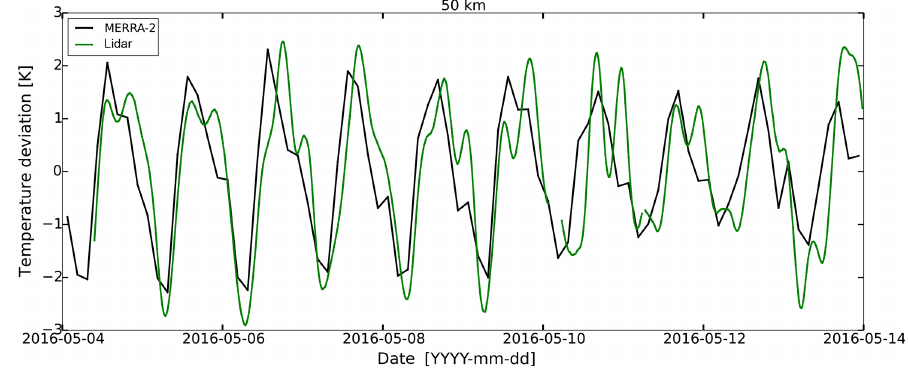
Figure 3. Comparison of tidal temperature fluctuations from the lidar (green) and MERRA-2 data (black).